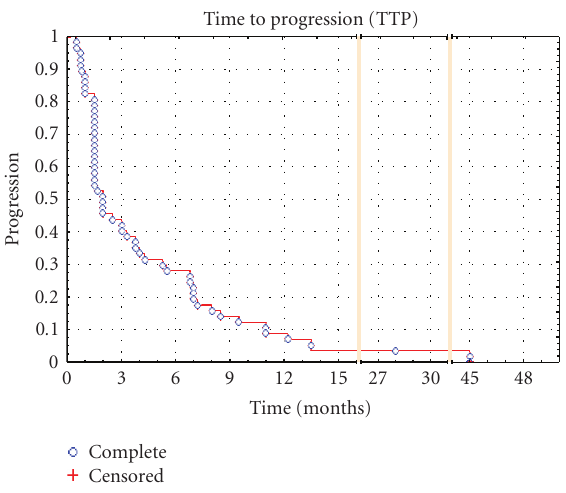
Figure 3: Kaplan-Meier Curve of time to progression for the STS subgroup.